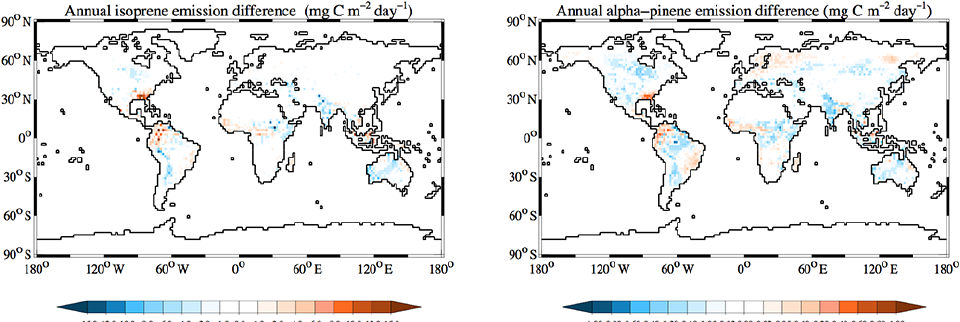
Figure 14. (a) Annual isoprene emission differences (TEST-NUDG minus reference simulation), and (b) annual α -pinene emission differ- ences (TEST-NUDG minus reference simulation).